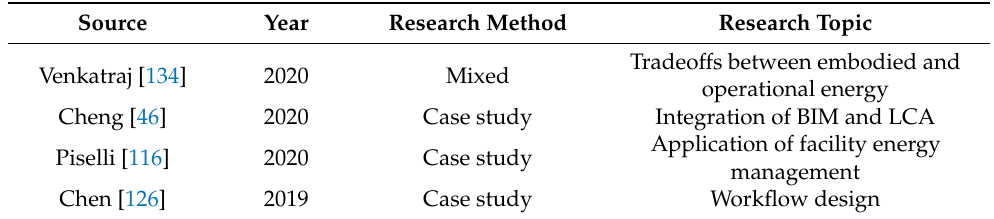
Table 4. The role of BIM in the operation and maintenance stages in terms of carbon emissions (generated by the